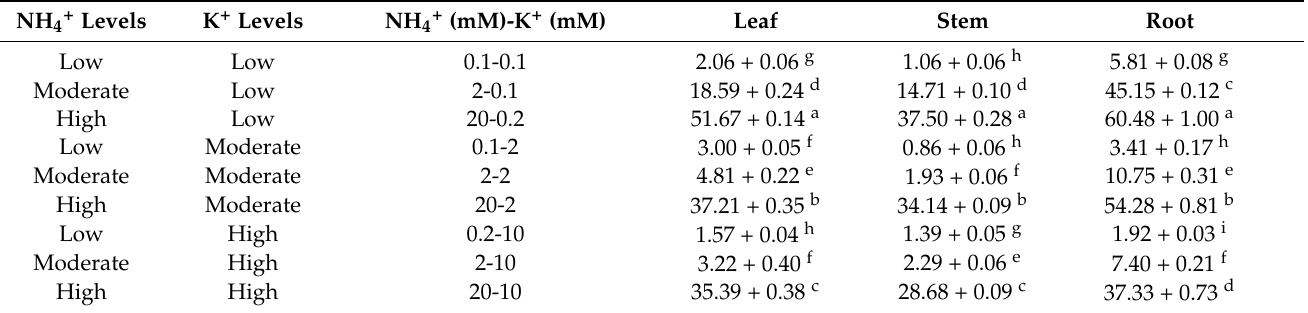
Table 4. Ammonium (NH 4+ ) ( µ mol g − 1 FW) concentrations in tobacco seedlings’ leaves, stems, and roots under different NH 4+ and K +